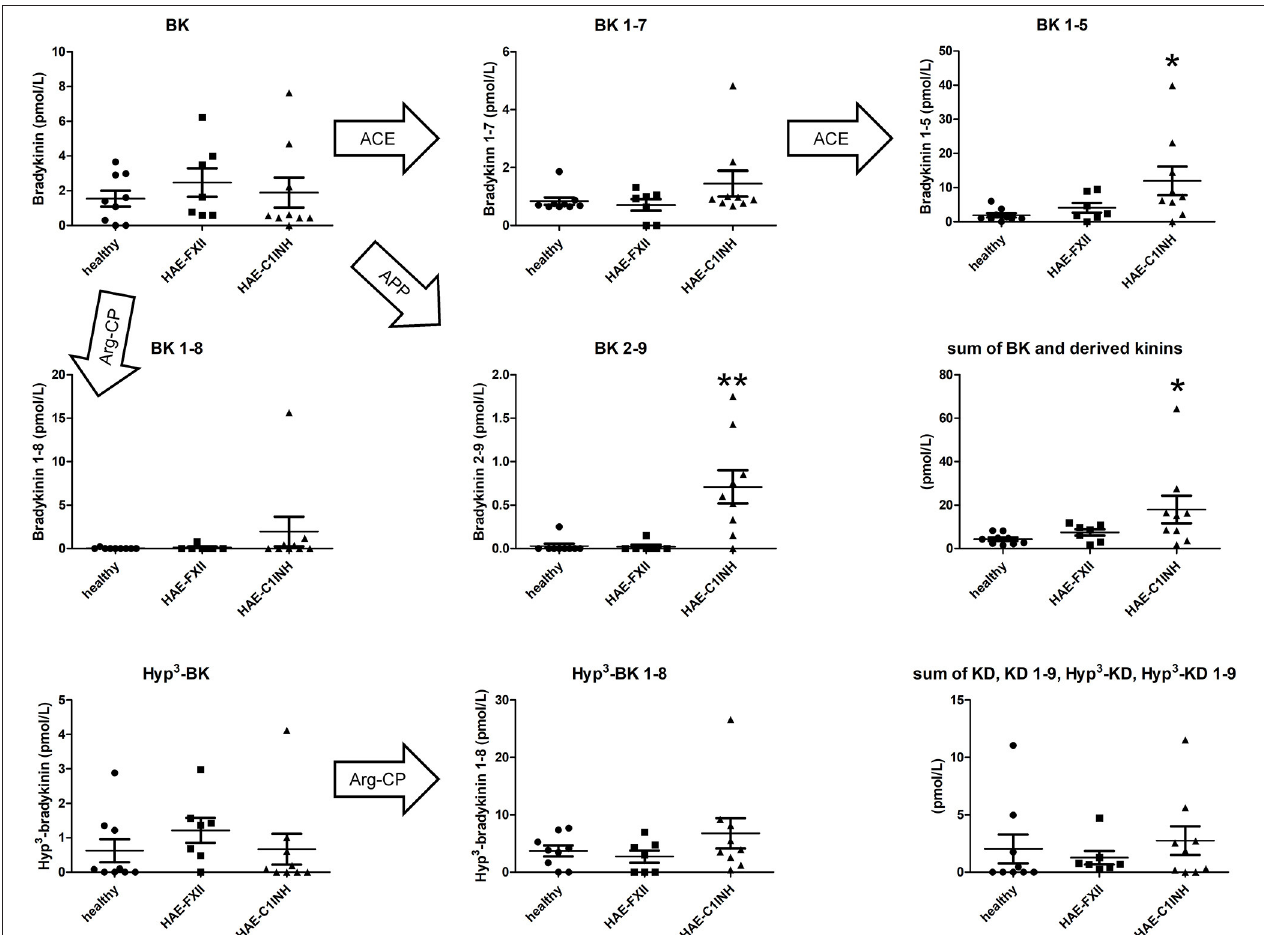
FIGURE 1 | Top rows: concentration of various BK-related peptides determined in the plasma of venous blood from healthy volunteers or patients with HAE-FXII or HAE-C1INH in remission (demographic data in Table 1 ). An additional panel (second row, right) shows the sum of BK and its fragments for each individual, presumed to represent the minimal concentration of kinins derived from plasma kallikrein activity. Bottom row: concentration of additional kinins. Individual values are shown. Horizontal bars are the mean, and the intervals the S.E.M. The Kruskall-Wallis test was applied to compare the effect of diagnostic categories. When significant, Dunn’s multiple comparison test was applied to compare the values from each type of HAE patients to those of the healthy controls. * P < 0.05; ** P < 0.001. Arrows indicate metabolic derivation of peptides from BK or Hyp 3 -BK via the action of peptidases. ACE, angiotensin-I converting enzyme; APP, aminopeptidase P; Arg-CP, arginine carboxypeptidases; BK, bradykinin; Hyp, hydroxyproline; KD, kallidin ( = Lys-BK); S.E.M., standard errors of the